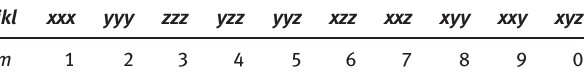
(second subscript is 29